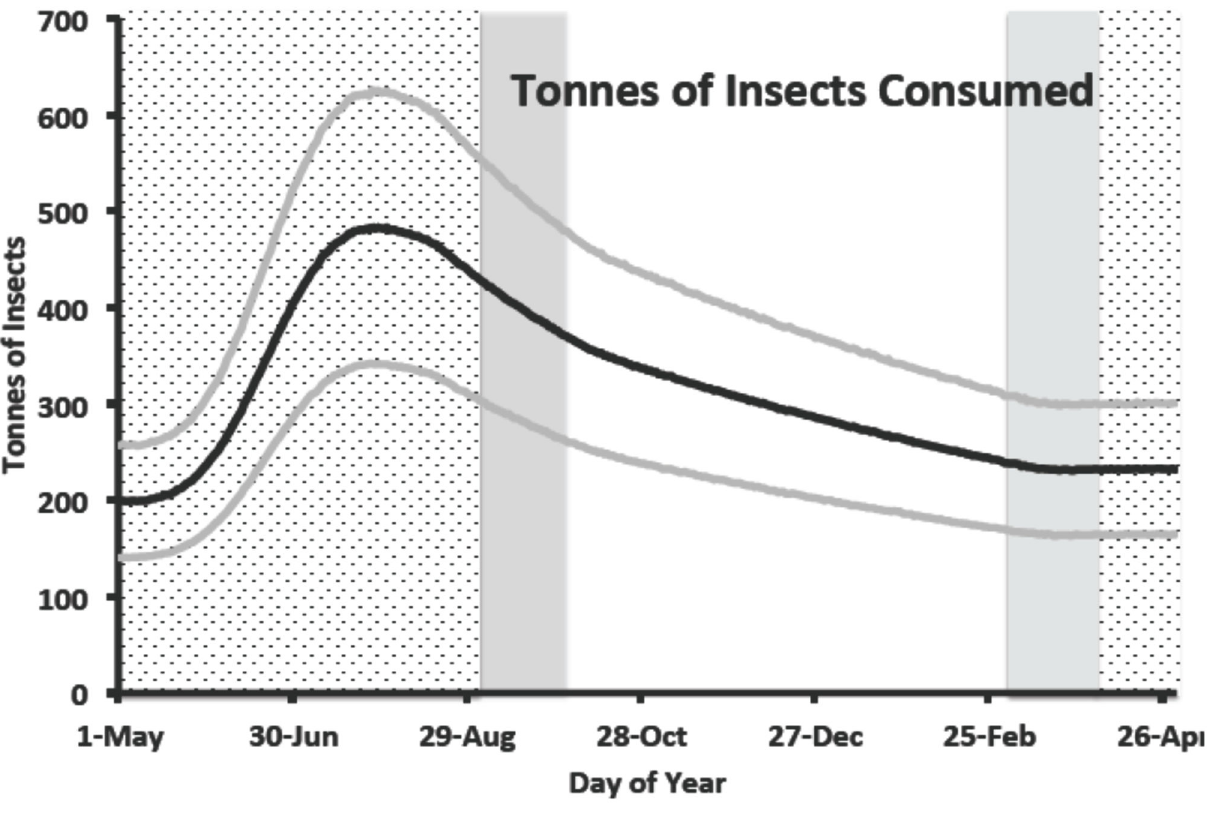
Figure 4. Estimated mean mass (in tonnes, black line) ± standard deviation (gray lines) of insects consumed by Purple Martins based on 10,000 replications of an energetics simulation model. Background shading indicates phase of the annual cycle as breeding season (stippling), migration (gray), and winter (no shading).